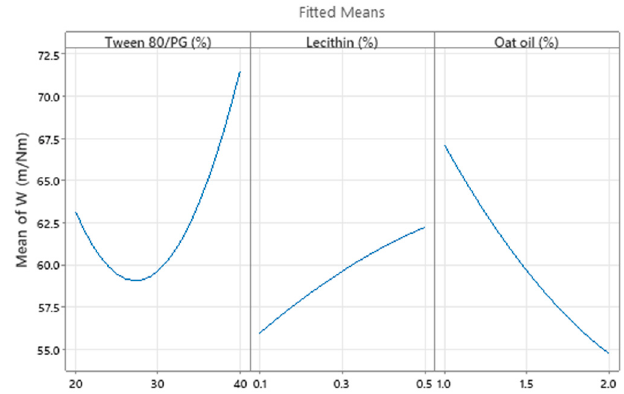
Figure 24. Main effects plot for W response (Y 3 ), considering individual effect of each independent variable.